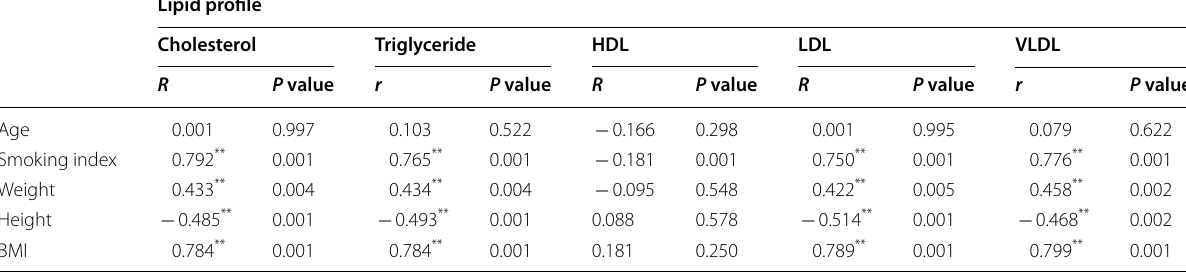
Table 8 Correlation between lipid profile and demographic